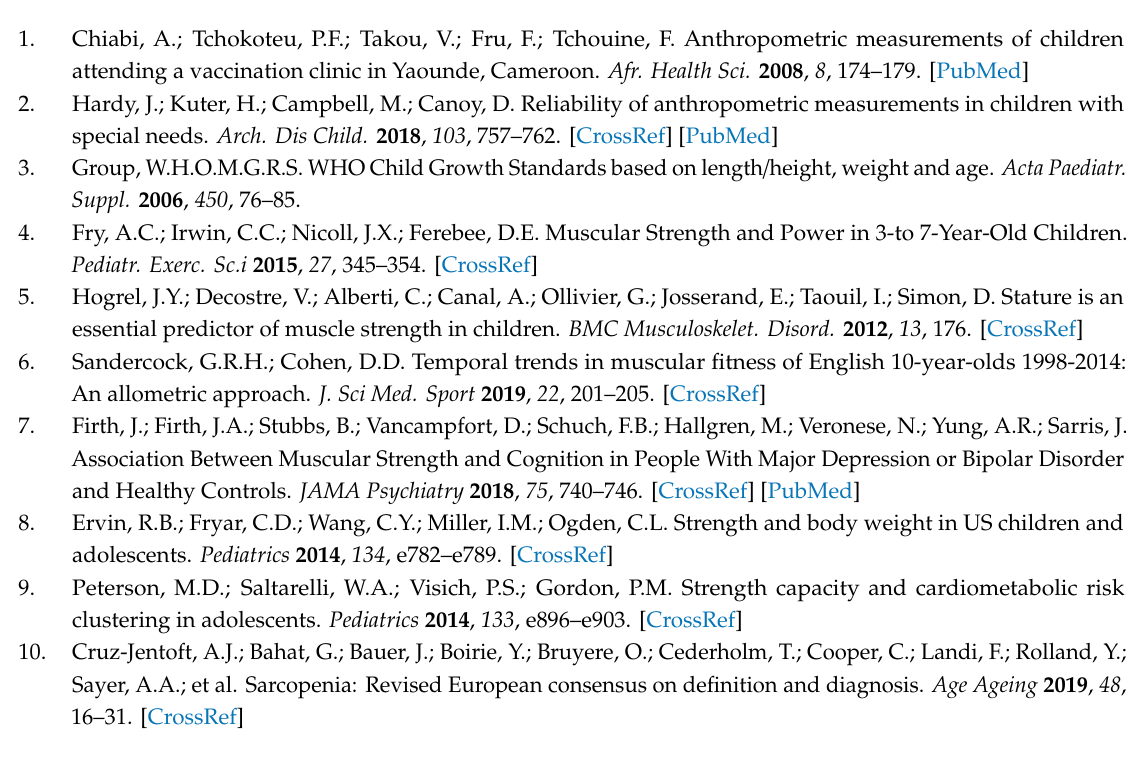
Table S1: General di ff erences in 10–18-year-old children and adolescents according to gender and age. Author Contributions: H.K. and H.L. were the group leaders; Y.K., H.L., and H.K. performed the conceptualization; J.K. and D.-Y.K. conducted the formal analysis; J.K., D.-Y.K., S.K., and S.P. worked with software. All authors have read and agreed to the published version of the